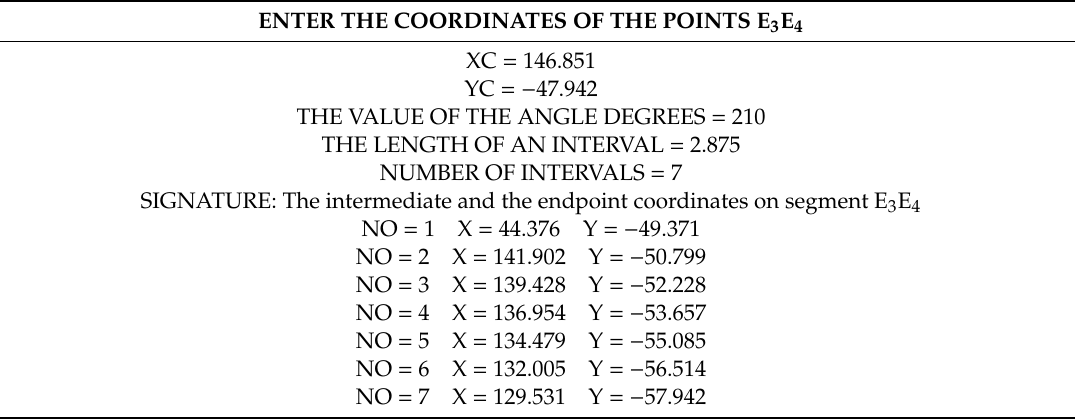
Table 4. The results of automatic calculation of characteristics points—direct E 3 E 4 .